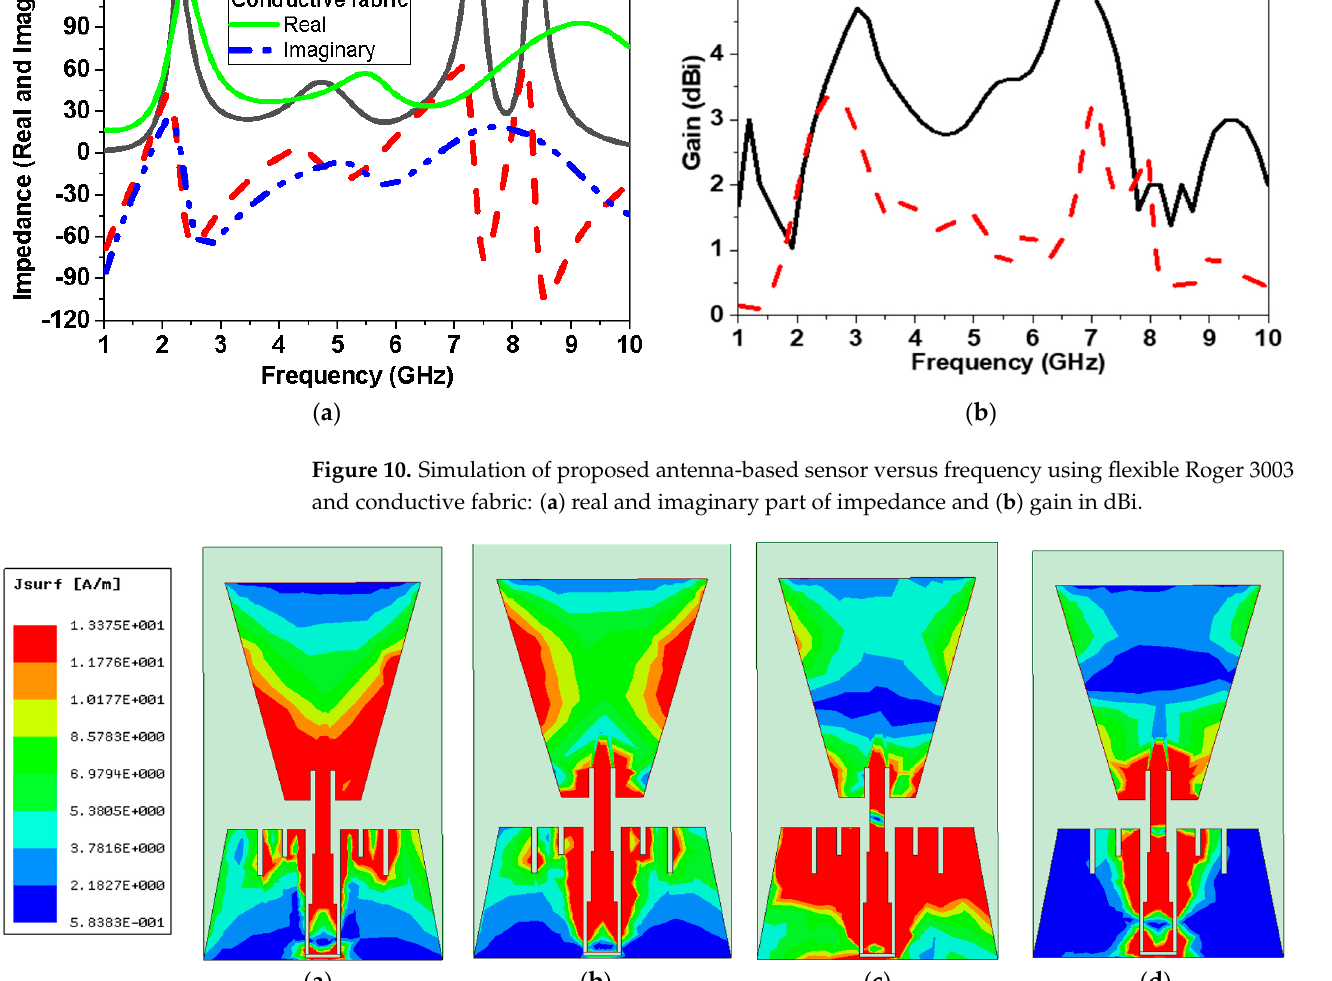
Figure 10. Simulation of proposed antenna-based sensor versus frequency using flexible Roger 3003 and conductive fabric: ( a ) real and imaginary part of impedance and ( b ) gain in dBi.